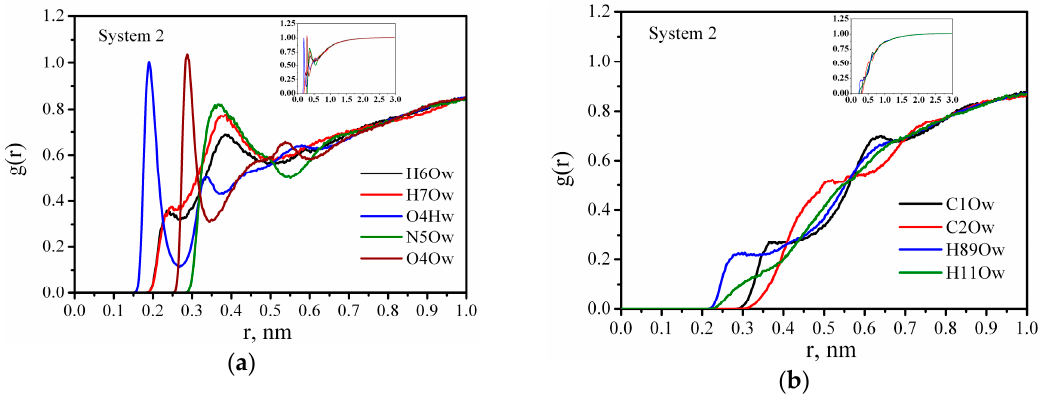
Figure 4. Atom–atom radial distribution functions for PAM in water: System 2. ( a ) The radial distribution functions of oxygen Ow and hydrogen Hw water atoms around the polymer atoms H6, H7, O4, N5, and O4 in System 2; ( b ) the radial distribution functions of oxygen Ow water atoms around the polymer atoms C1, C2, H8,9, and H11 in System 2.